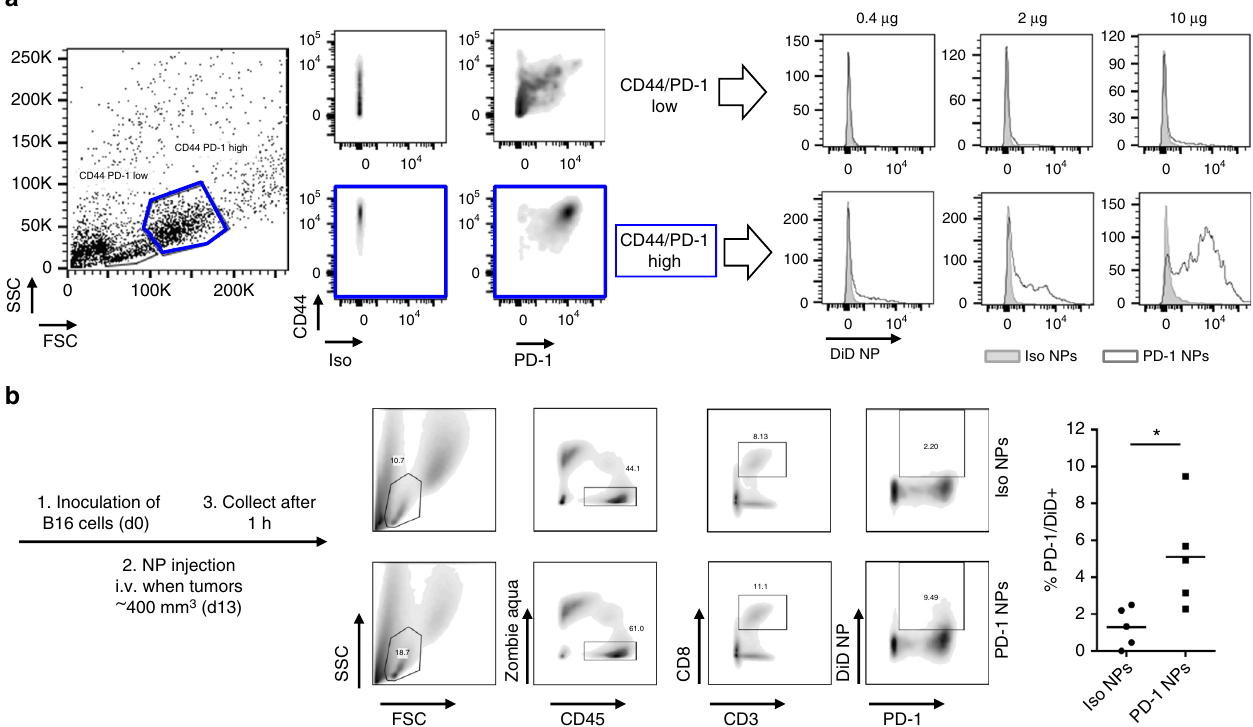
Fig. 3 PD-1-targeting nanoparticles bind to T cells in vitro and in vivo. a CD8 + OT-I T cells were activated with ovalbumin-expressing B16 (ratio 1:10 B16 to T cell) for 48 h and incubated with DiD-loaded, PD-1-targeting nanoparticles for 30 min before detection of DiD by fl ow cytometry. Mass of polymer indicated is per 250,000T cells. b C57BL/6 mice were inoculated subcutaneously with ovalbumin-expressing B16 melanoma cells. Once tumors reached ~400 mm 3 in volume, DiD-loaded, PD-1-targeting or isotype control nanoparticles were injected intravenously. 1 h later, tumors were recovered. Flow cytometry was performed (gating shown at left), and the percentage of T cells that were positive for both PD-1 expression and nanoparticle binding was quanti fi ed (right panel); n = 5 (* p < 0.05, Two-tailed Student ’ s t